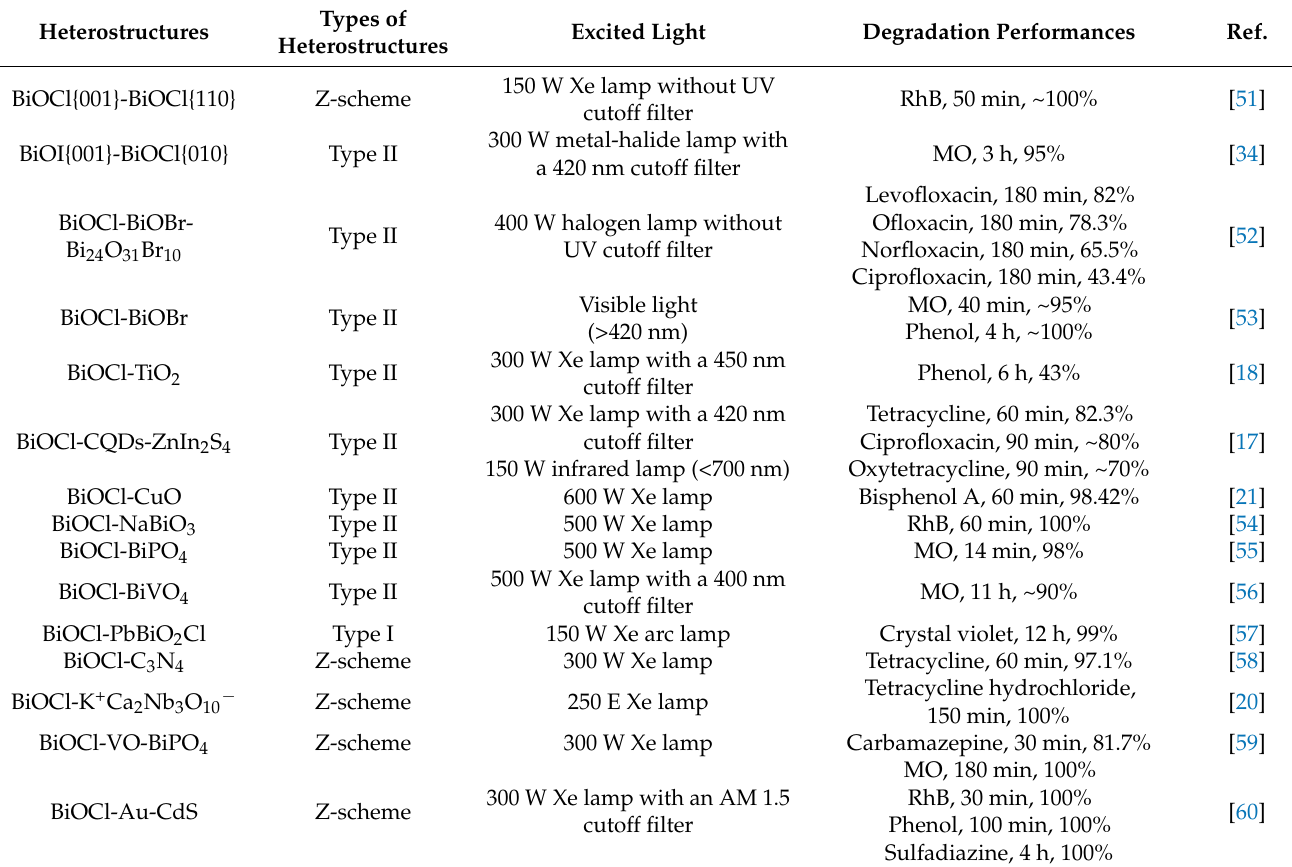
Table 1. BiOCl-based heterostructures for improving photocatalytic degradation